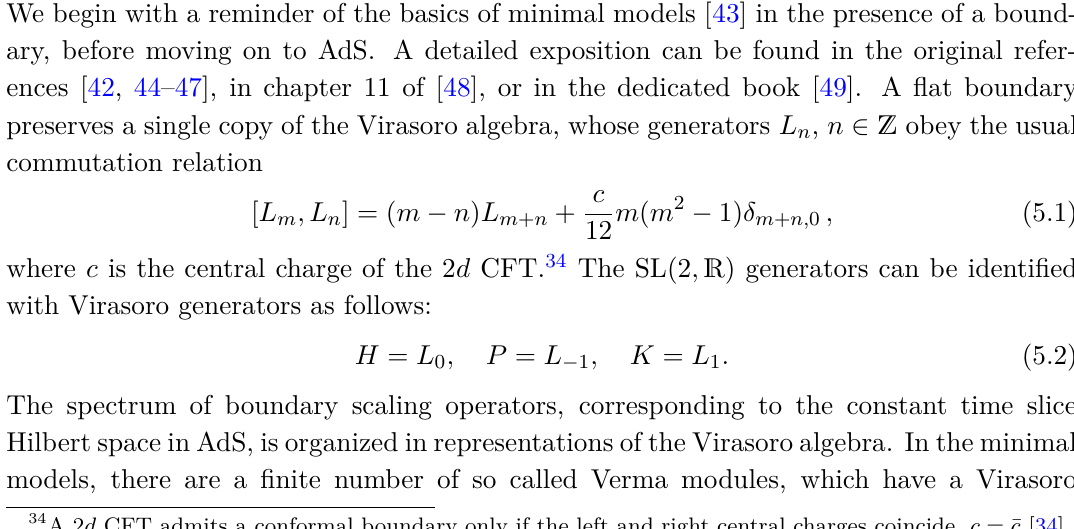
Figure 14. Mass gap of the φ 4 Hamiltonian (4.26) for a range of quartic couplings a different set of UV scaling dimensions ∆ (different curves, see